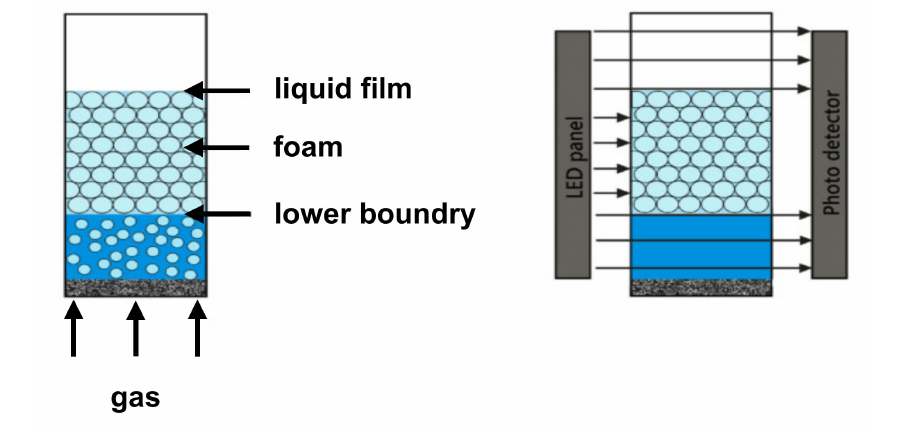
Figure 2. Foaming and height detection by means of the